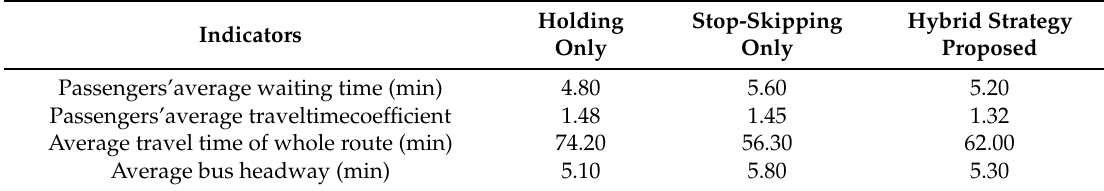
Table 4. Comparison of results among the three